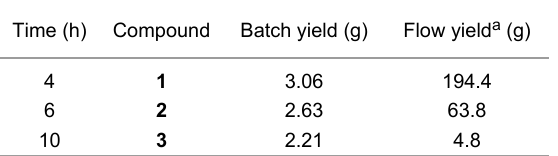
Table 1: Batch versus flow comparison. Time